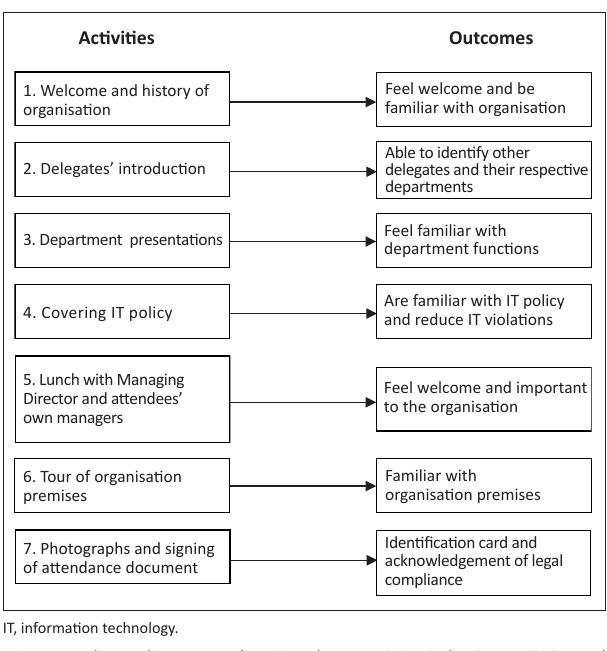
FIGURE 1: The media company’s action plan containing induction activities and their related outcomes.